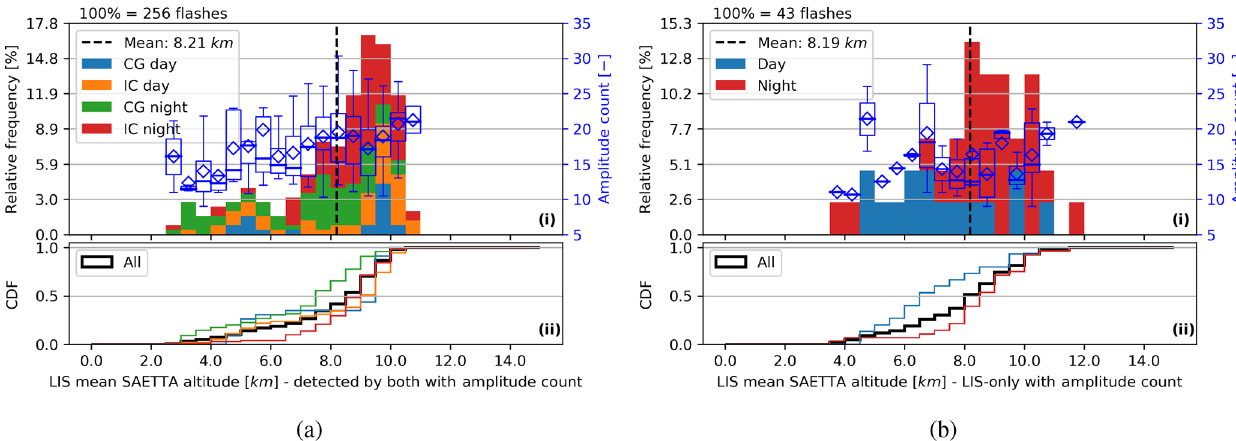
Figure 13. Flash mean altitude of ISS-LIS flashes (from concurrent SAETTA observations) with a coincident Meteorage flash (a) and un- matched ISS-LIS flashes (b) . Daytime, nighttime and flash type, IC and CG, are indicated by the colors. The histogram (i) and corresponding CDF (ii) use the same colors. The CDF additionally shows a black curve for all data. The histogram bin width equals 0.5km. Note: the CG–IC attribute for an ISS-LIS flash needs the matched Meteorage flash and does not exist for ISS-LIS-only flashes. The mean value is plotted as a dashed line. The total number of flashes is indicated above the histogram. The blue box plots (median as a line, mean as a diamond, interquartile range – IQR – as a box, 1.5 IQR as whiskers; outliers not plotted) represent the distributions of the ISS-LIS mean event amplitude count per flash for each altitude bin.